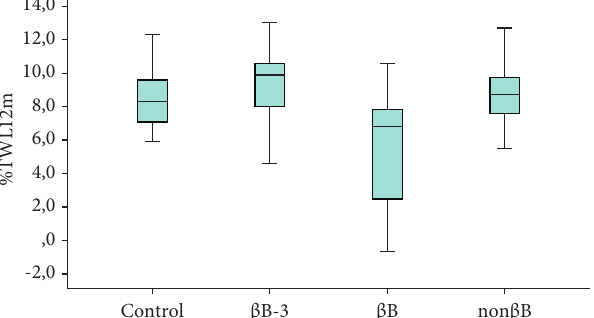
Figure 3: Percentage of TWL after 12 months in the 4 groups: the mean TWL% value of the bB group after 12 months resulted to be 5.69 ± 3.33, versus 8.83 ± 1.70 of the non-bB group and 8.54 ± 1.63 of